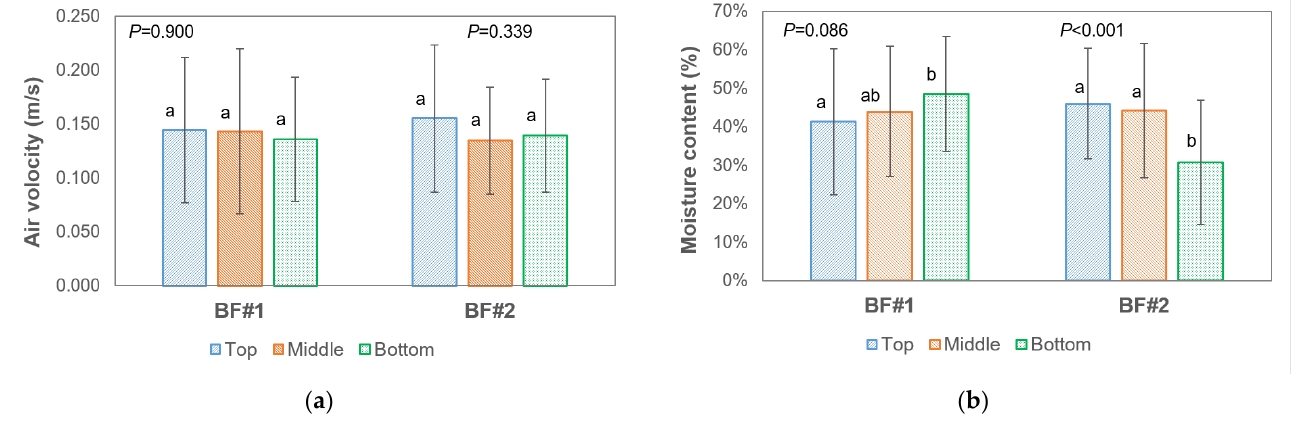
Figure 4. ( a ) Average air velocity and ( b ) average woodchip moisture content at the upper, middle, and lower rows of each biofilter. Non-parametric ANOVA was performed for comparison. The rows annotated with the same letter were not significantly different.